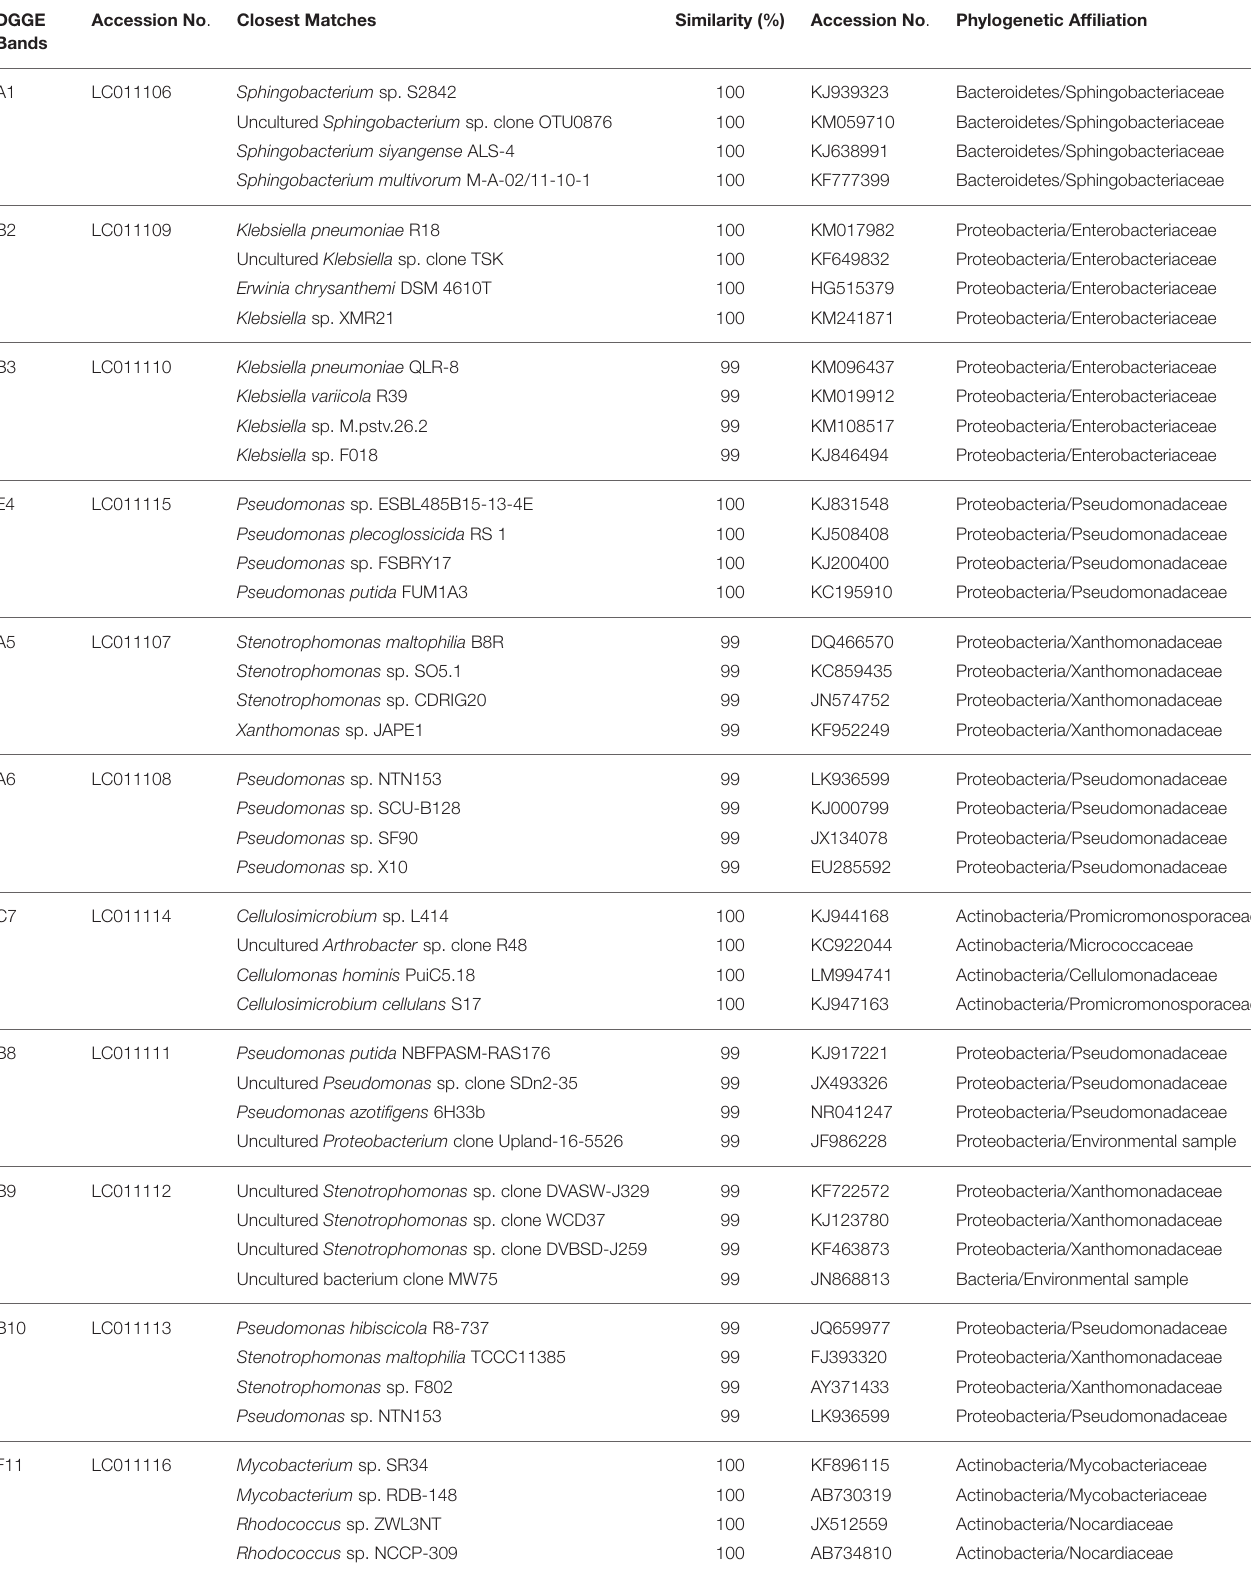
TABLE 2 | Bacterial species identified in AK6 cultures and their phylogenetic affiliations. DGGE Accession No Bands